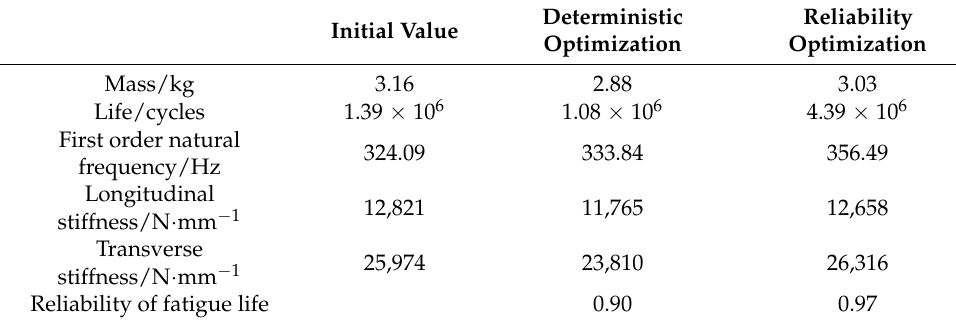
Table 8. Comparison of optimal design